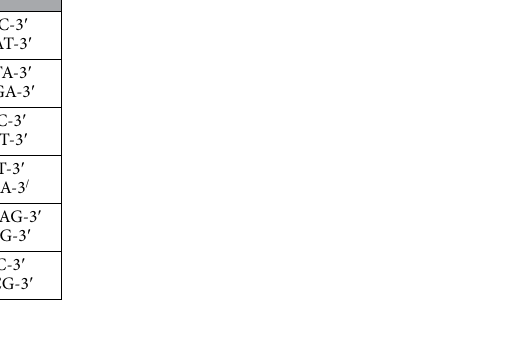
Table 1. List of